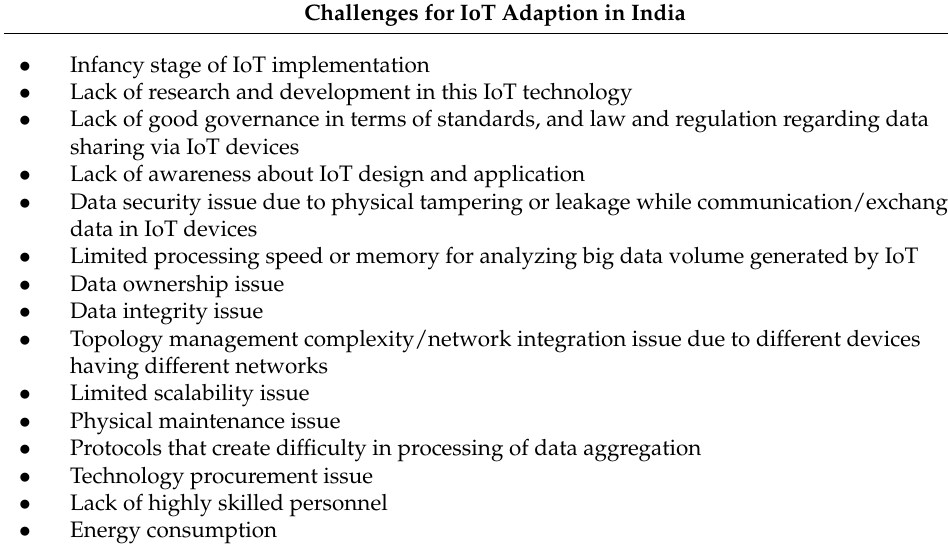
Table 4. IoT adaption challenges in Indian insurance industry.